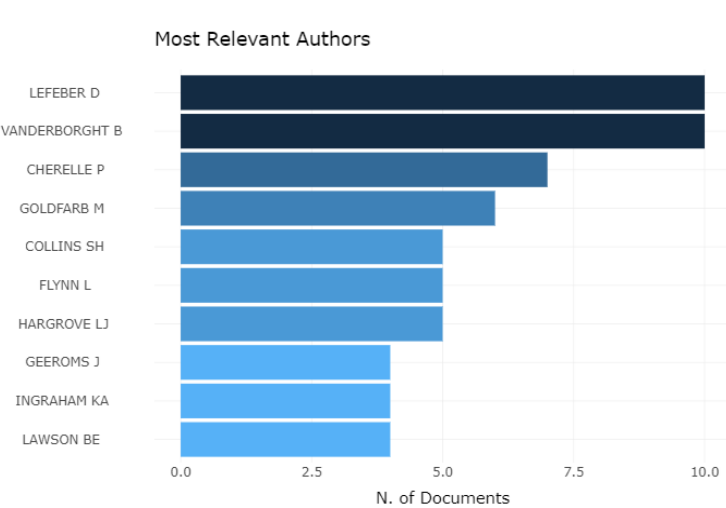
Figure 6. Top 10 most relevant authors on lower limb prosthesis design.